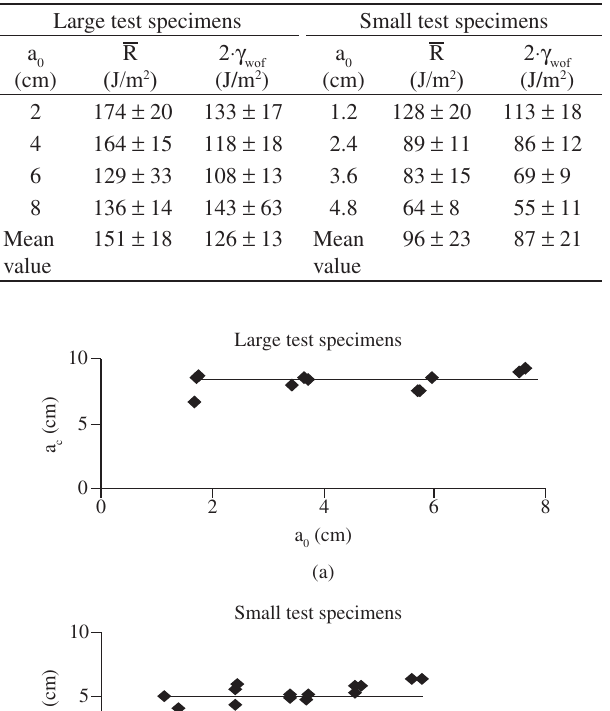
for the material under study. wof